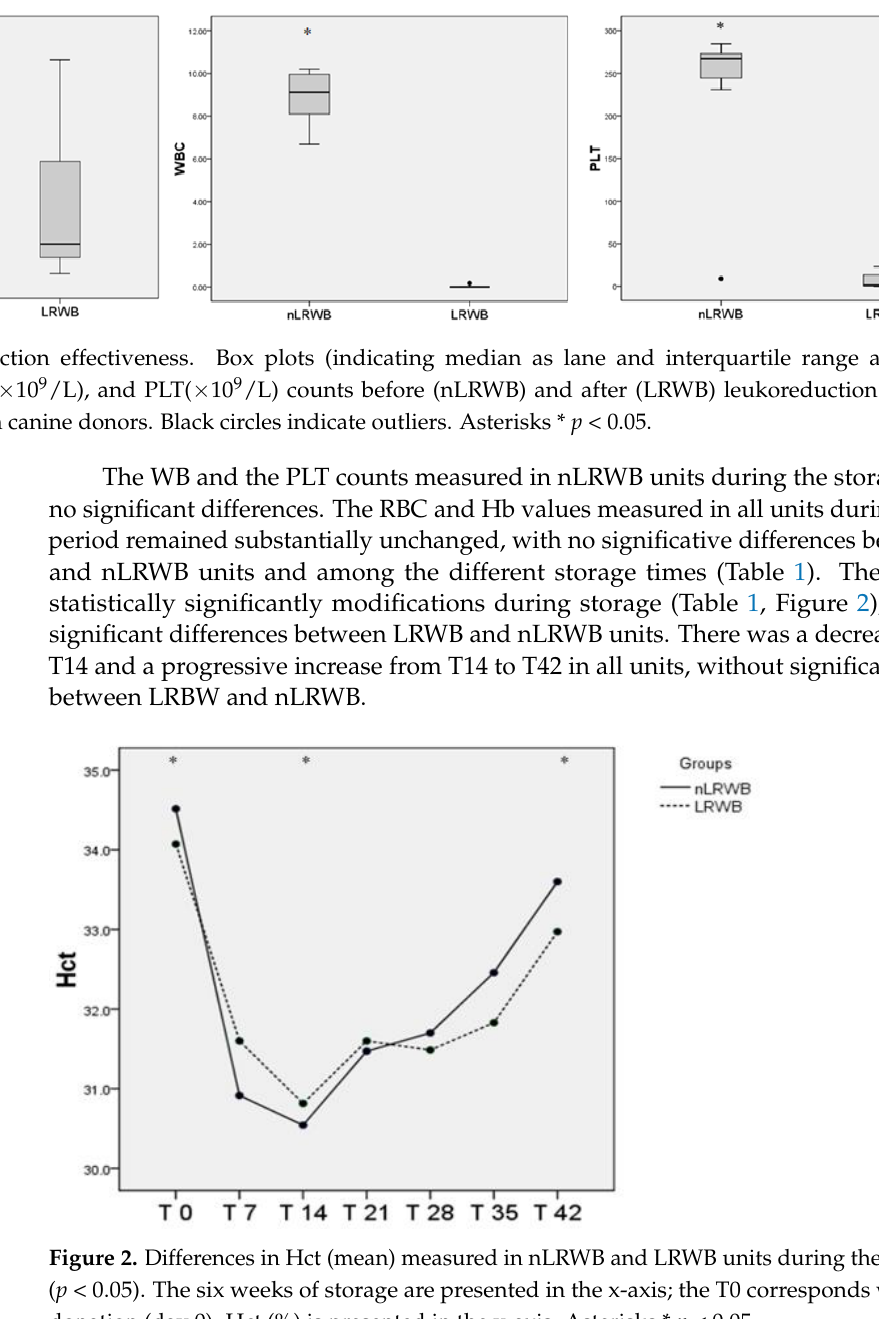
donation (day 0). Hct (%) is presented in the y-axis. Asterisks * p < 0.05.